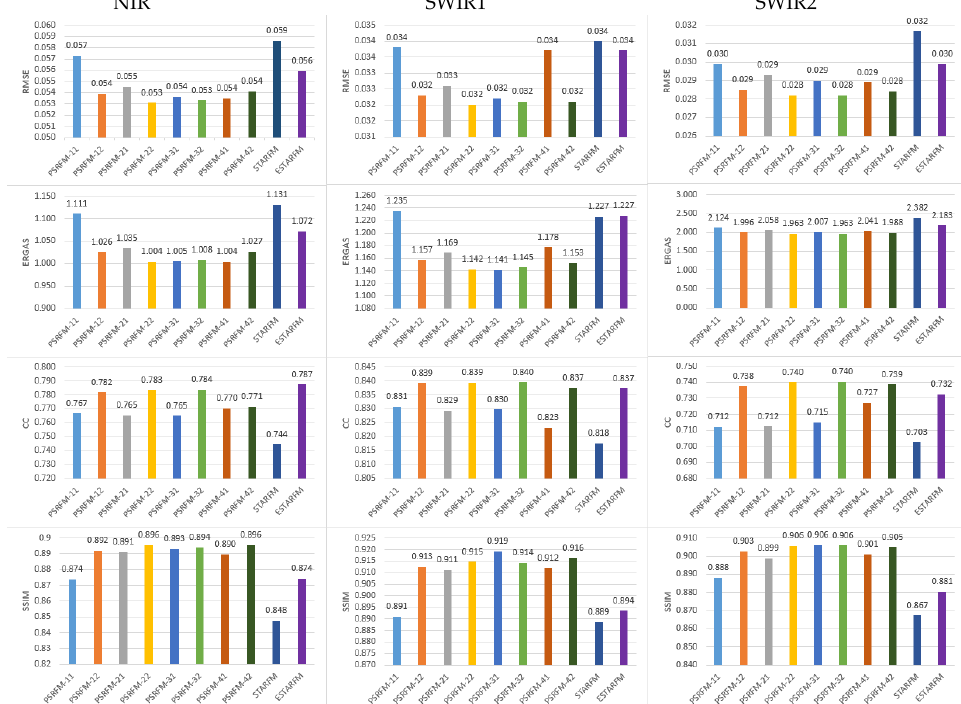
Figure 11. Area enlarged for visual comparison of the burning area observed by Sentinel-2 MSI image ( a ) and ( b ) (same as ( a ) but marked with the unavailable pixel values of the MODIS image on the prediction date for purpose of comparison) on 15 August 2018 and predicted images ( e – l ) by PSRFM- ij ( i = 1, 2, 3, 4, j = 1, 2), ( c ) STARFM and ( d ) ESTARFM using two pairs of Sentinel-2 MSI and MODIS BRDF adjusted images acquired on 31 July 2018 and 22 September 2018, respectively. All images are in SWIR1-NIR-SWIR2 (R-G-B) false color composites. The two small rectangles shown as black indicate that no MODIS data are available for all the bands on the prediction date 5 August 2018, while the areas with variation of cyan color indicate that no MODIS data are available from the SWIR1 band.